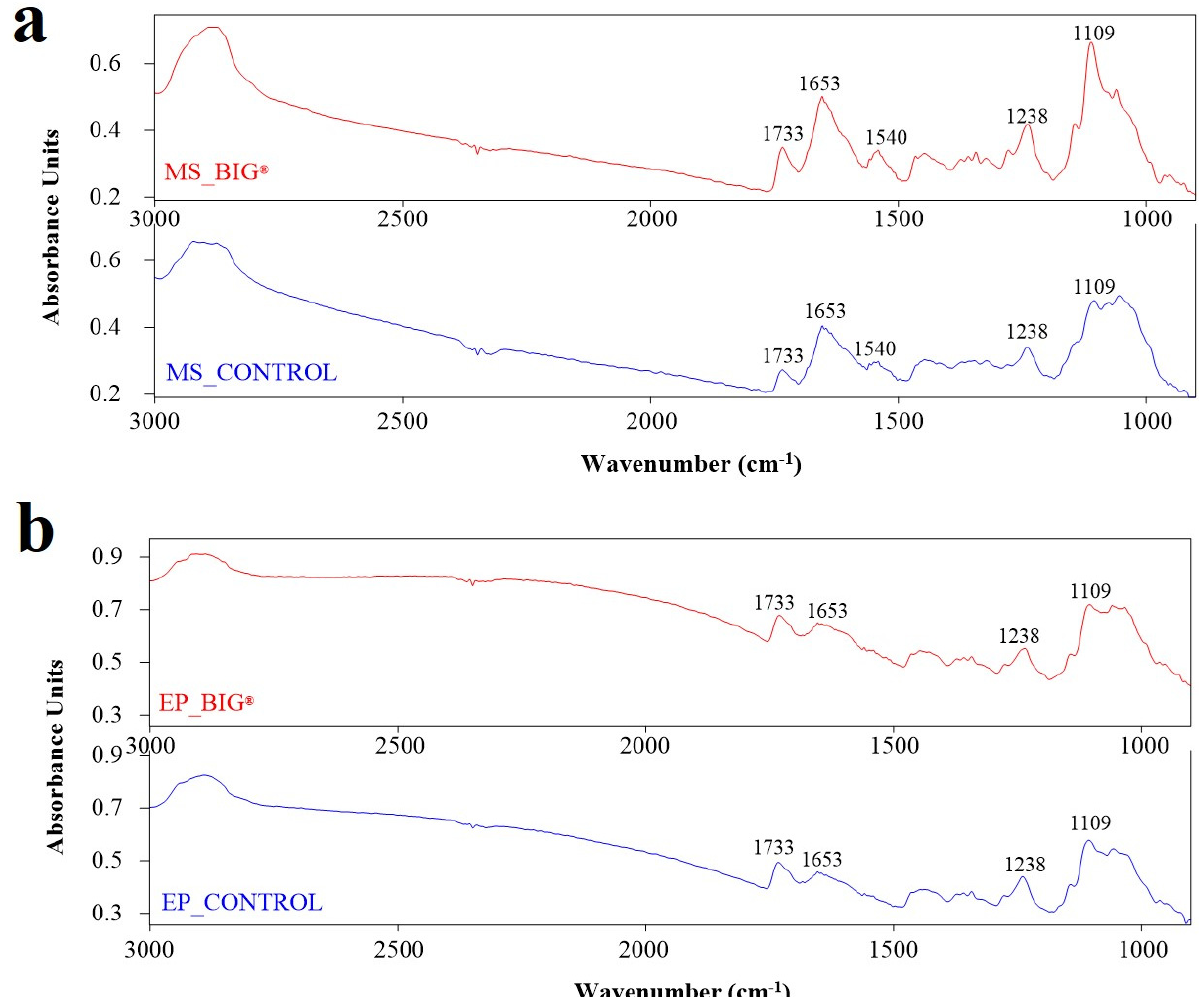
Figure 5. FTIR spectra corresponding to the regions of the mesophyll and epidermis from rice leaves of cv. KDML 105 in response to an inoculation challenge with Xoo at 14 DAI under greenhouse conditions. ( a ) Mesophyll of rice plants after inoculation challenge with BIG ® compared with the control. ( b ) Epidermis of rice plants after inoculation challenge with BIG ® compared with the control.